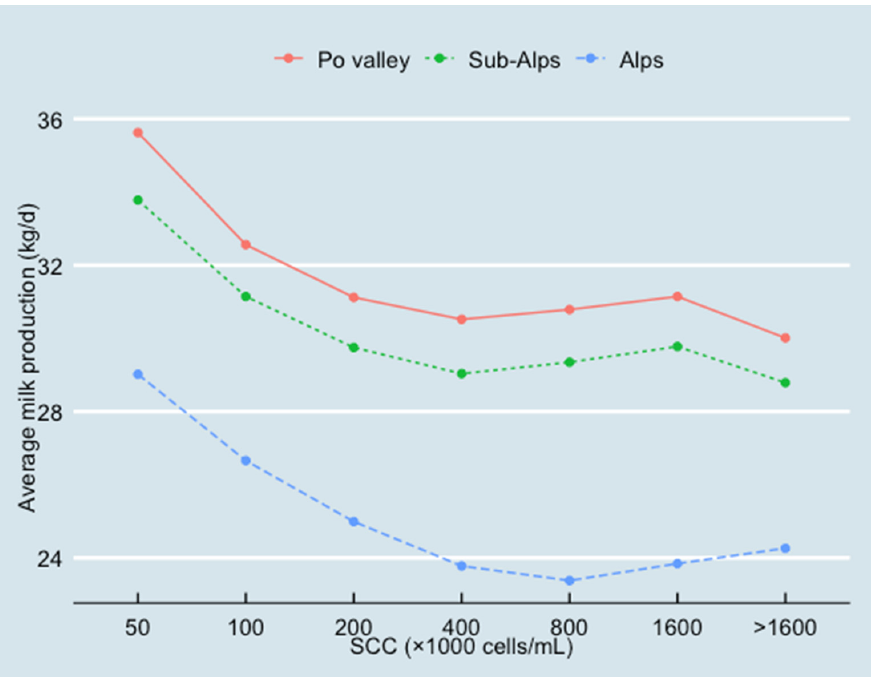
Figure 5. Relationship between SCC and average milk production (10,445,464 test-day records from 826,831 cows in 2970 herds) classified by the three geographical areas (Po Valley, sub-Alps and Alps).